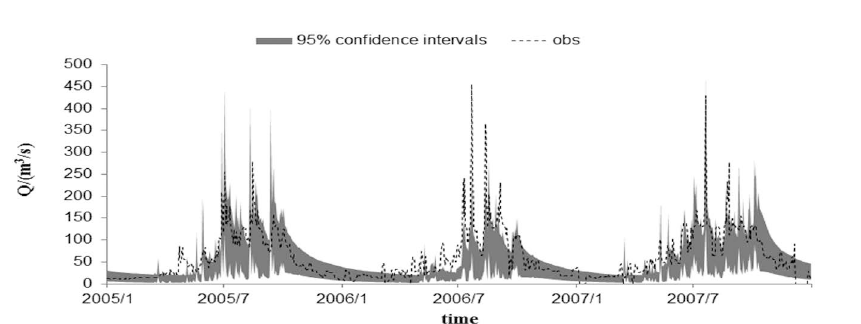
Fig. 4 Uncertainty intervals calculated for runoff event at 95% confidence